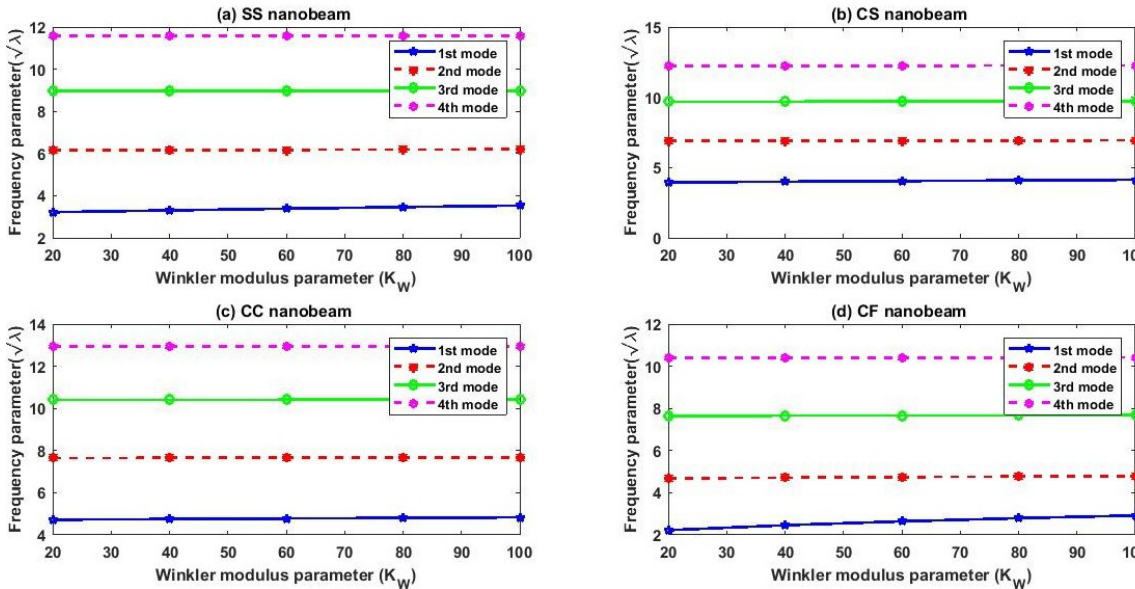
Figure 6: Variation of frequency parameter with Winkler modulus parameter